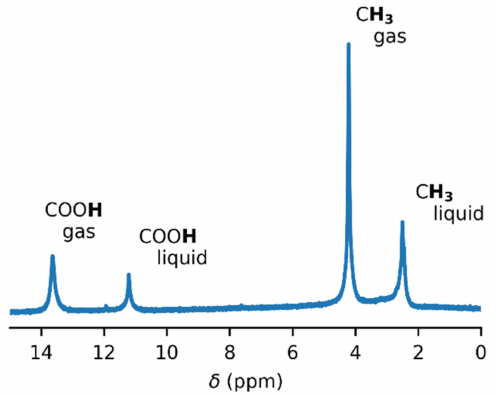
Figure 1. The 1 H–NMR spectrum of acetic acid in a glass insert at the temperature of 60 ◦ C. The spectrum was not